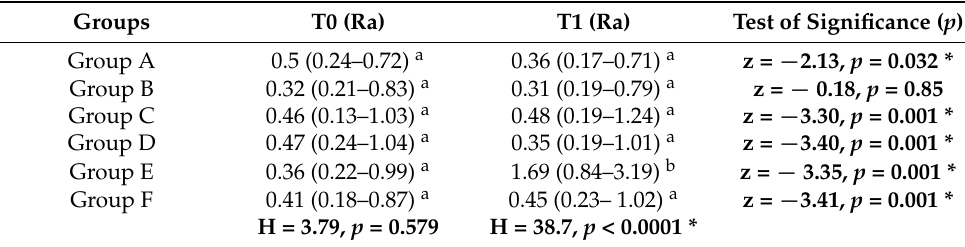
Table 2. Comparison of surface roughness (Ra) of within and between the study groups, at baseline and after treatment.